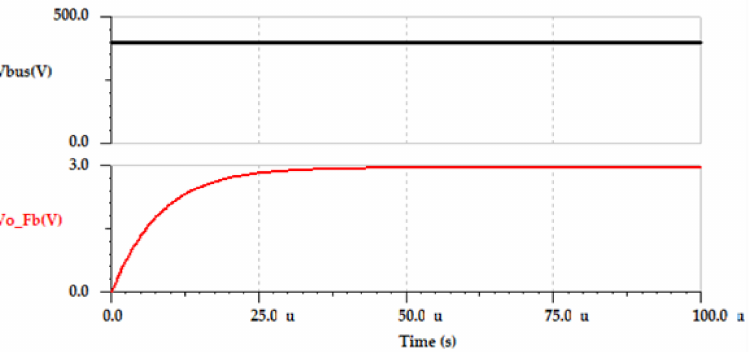
Figure 20. Isolated DC voltage sensor voltage curves with input voltage of 400